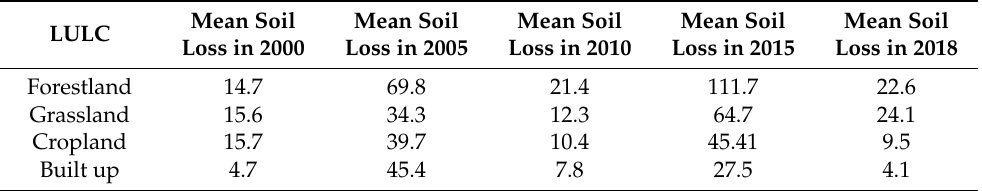
Table 6. Mean soil erosion (t/ha/yr) per each LULC